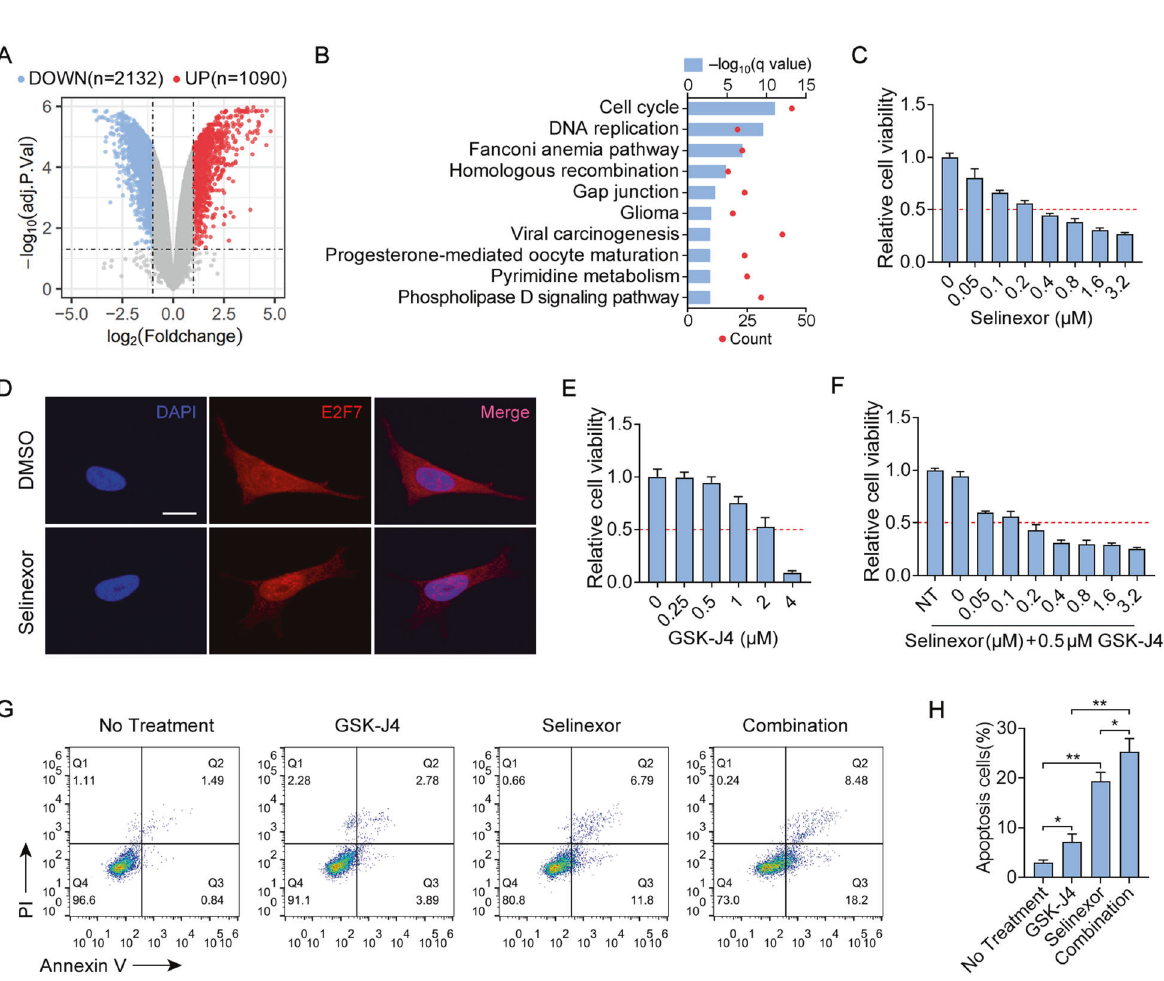
Fig. 5 Selinexor suppresses the growth of NB and combines with GSK-J4 to enhance NB regression. A Volcano plot of all expressed genes is shown to identify DEGs obtained from microarray study (GSE180601) in Selinexor-treated SK-N-BE(2) cells with abs(log 2 (fold change)) >1 and adjusted p value <0.05. B KEGG pathway analysis for DEGs. C CCK-8 assays for SK-N-BE(2) cells treated with the indicated concentrations of Selinexor for 72 h. D Immuno fl uorescence confocal images showing the subcellular distribution of E2F7 in SK-N-BE(2) cells treated with 0.4 μ M Selinexor for 24 h. E CCK-8 assays for SK-N-BE(2) cells treated with the indicated concentrations of GSK-J4 for 72 h. F CCK-8 assays for SK-N-BE (2) cells treated with 0 or 0.5 μ M GSK-J4 and the indicated concentrations of Selinexor for 72 h. G , H Flow cytometry showing the apoptosis of SK-N-BE(2) cells treated with 0.5 μ M GSK-J4, 0.2 μ M Selinexor, or the combination for 48 h. Unpaired two-sided t -test for analysis in H , data were shown as mean ± SD (error bars). Data were representative of three independent experiments. genes as well as E2F target genes with well-established roles in Transcriptome analysis revealed that SAPCD2-knockdown led to CIN, including FBXO5, CDC20, and MAD2L1 [23 – 25], were alterations in genes involved in cell cycle, DNA replication, identi fi ed as being regulated by SAPCD2. Our data also nuclear division, and spindle formation, which are all key indicated that SAPCD2-knockdown led to a decreased E2F cellular processes modulated by E2F signaling and often activity in NB cells. deregulated in cancer. In particular, multiple cell cycle-related Cell Death and Disease (2022)